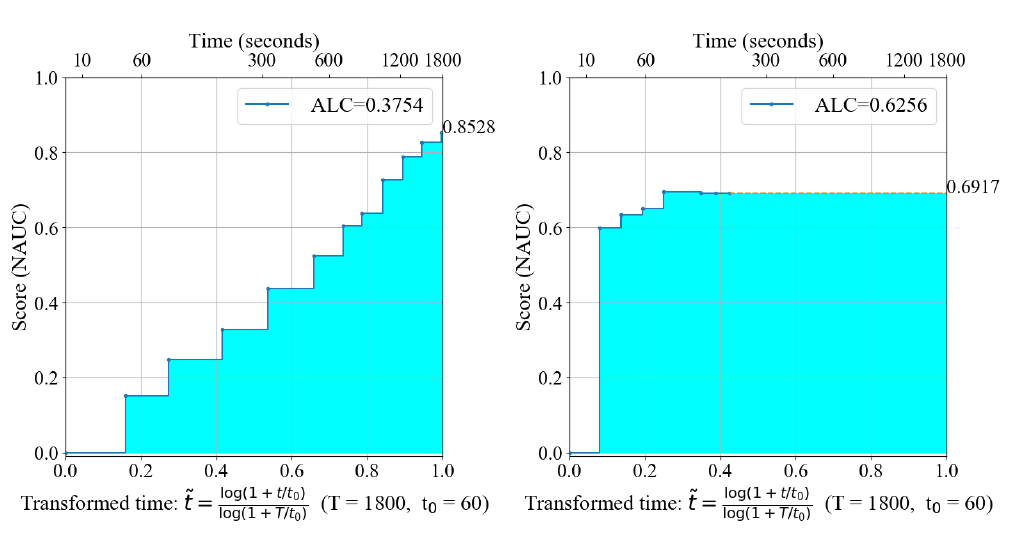
Figure 3. The performance trajectory of two example models during training to explain the used metrics. The model with faster training ( right ) scores better, in terms of ALC, than the model with higher final accuracy but slower training ( left ).